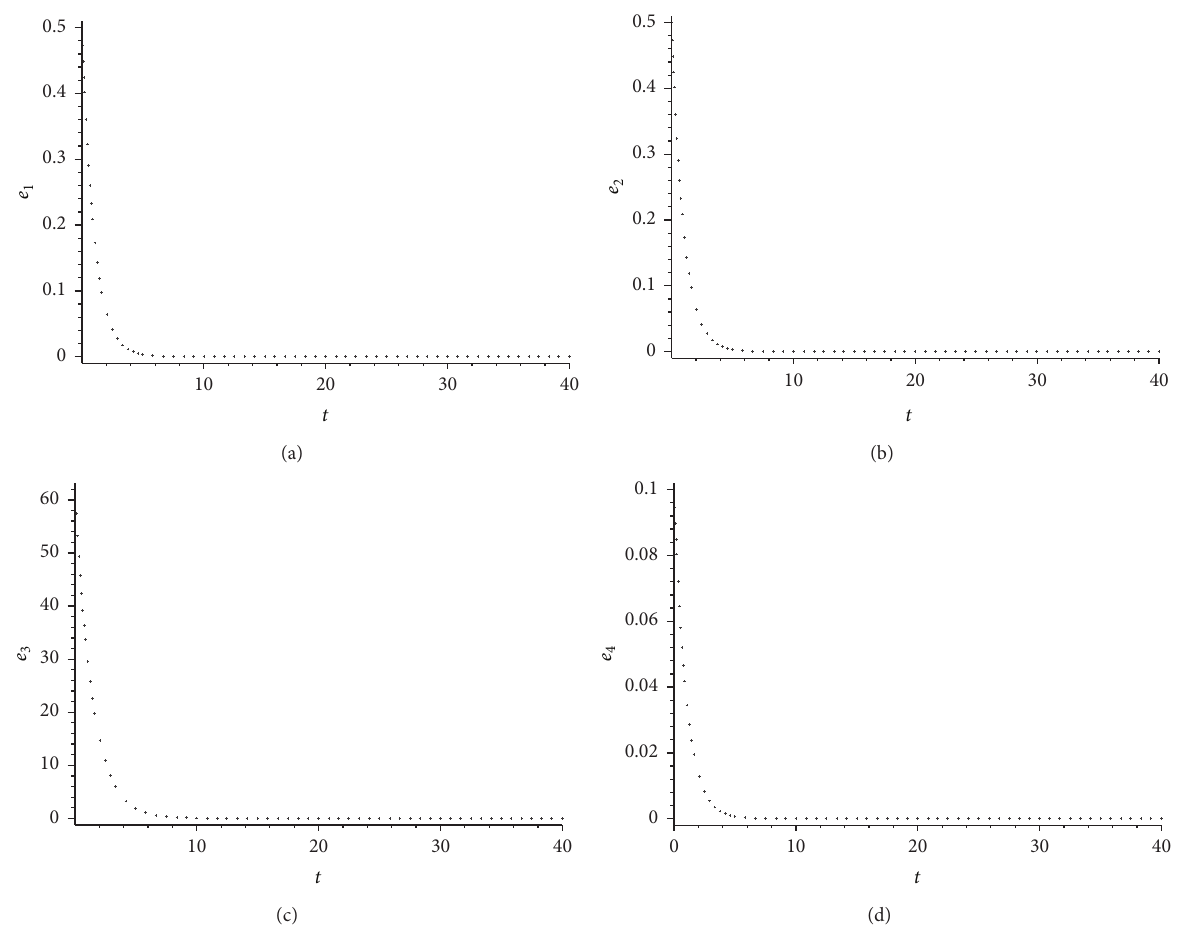
Figure 8: The dynamics of synchronization errors. (a) Signal 𝑒 1 , (b) signal 𝑒 2 , (c) signal 𝑒 3 and (d) signal 𝑒 4